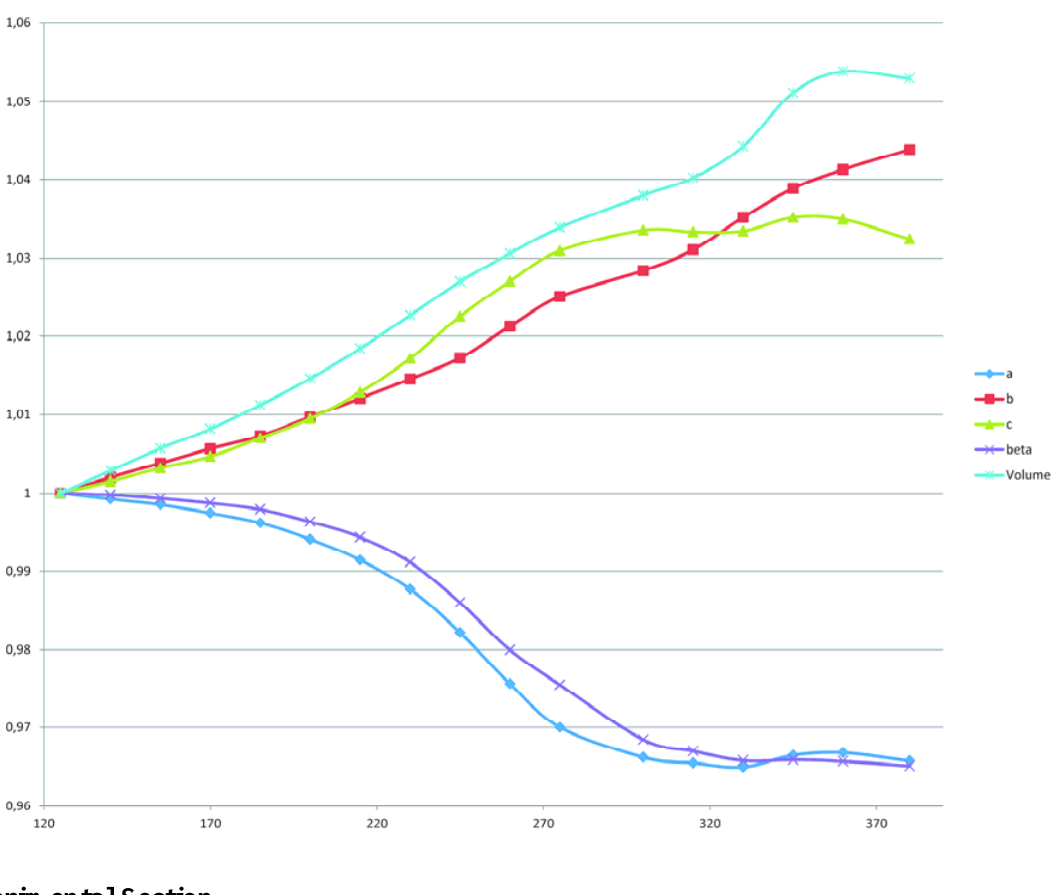
Figure 6. Temperature dependence of unit cell parameters and unit cell